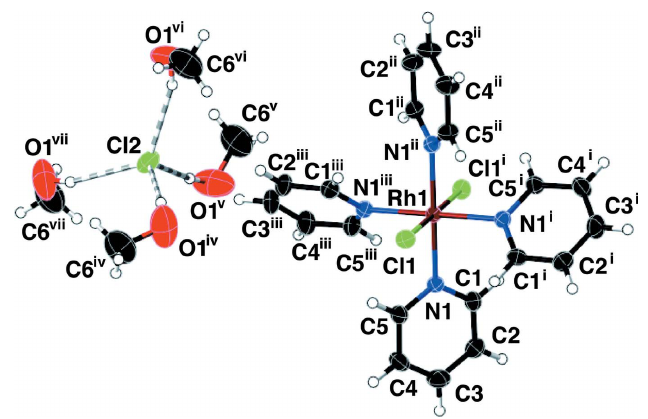
Figure 1 View of the molecular components of the solvated title salt, showing the atom-numbering scheme and displacement ellipsoids drawn at the 50% probability level. Hydrogen atoms are shown as an ideal sphere with a radius of 0.15 A˚ . The striped bonds indicate hydrogen bonds between Cl and H atoms. [Symmetry codes: (i) (cid:3) x , (cid:3) y , z ; (ii) (cid:3) y , (cid:3) x , (cid:3) z + 1 (cid:3) z + 1 ; (iv) (cid:3) x + 1, y + 1, z ; (v) (cid:3) y + 1, x , (cid:3) z ; (vi) y , x + 1, (cid:3) z 2